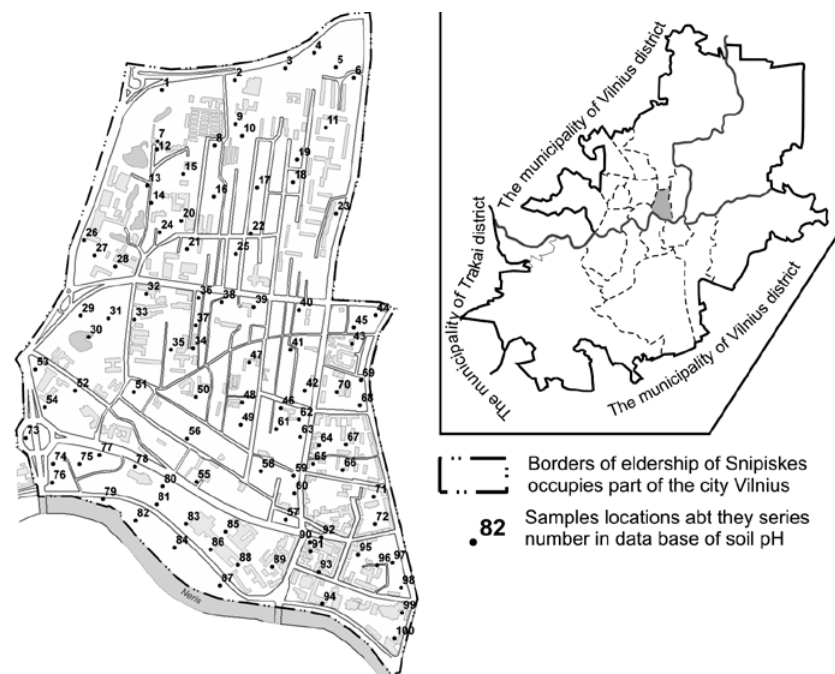
Fig. 1. Soil sampling specific locations (100 points) in eldership of Šnipiškės of the city